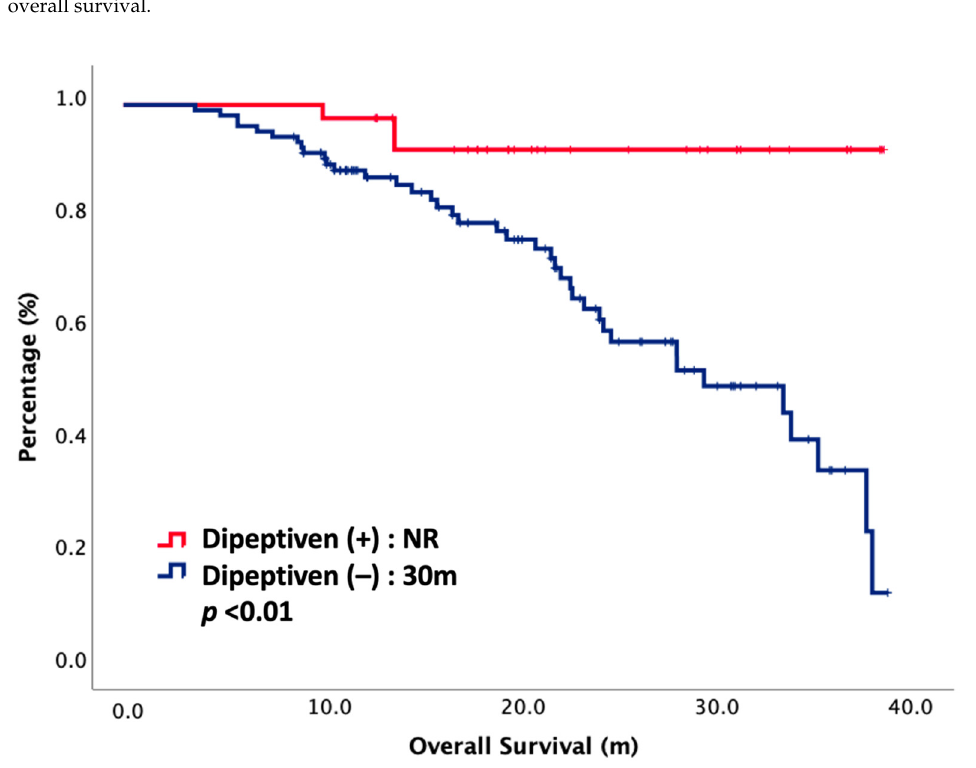
Figure 1. Overall survival of 144 NPC patients treated with CCRT, stratified by dipeptiven. NR, not reached.